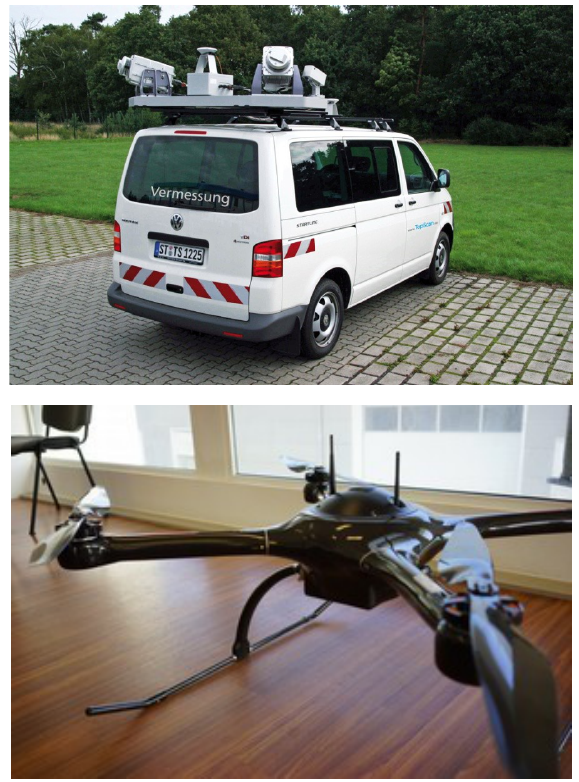
Figure 1: The mapKITE tandem: (Top) Spyro-4 UA, by UAVision (Portugal); (Down) Mobile mapping van by TopScan